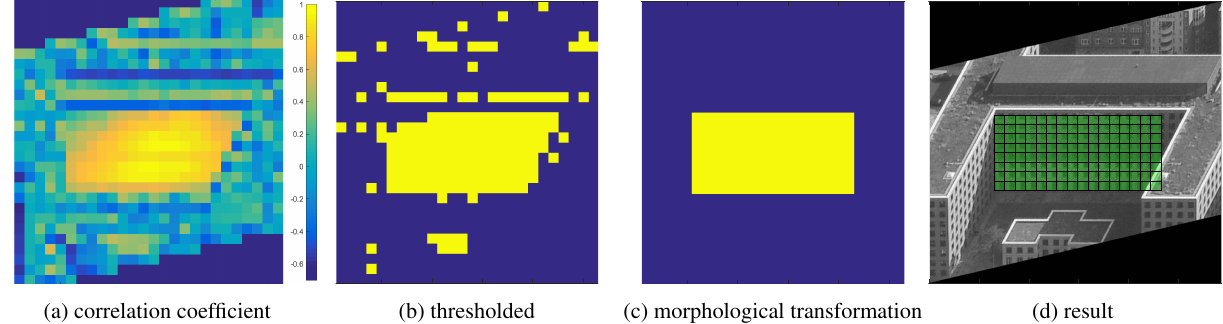
(a) correlation coefficient Figure 4. Process of estimating the extent of the facade regularity. (a) shows the correlation coefficient of every segment. The color codes the correlation coefficient. The facade structure as well as the occlusion by the orthogonal building part is visible. (b) displays thresholded binary image. The inter-class variance maximization yielded a threshold of 0.34 for this example. Patches with correlation coefficient about this threshold are marked in yellow. (c) depicts the thresholded result after a sequence of opening and closing. (d) shows the result of the extent estimation overlayed on the oblique image.